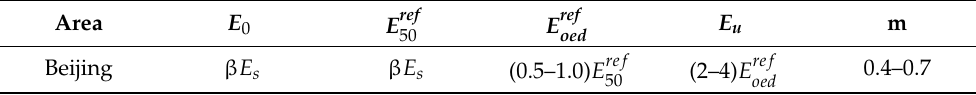
Table 2. Empirical values of nonlinear stiffness parameters of the modified Mohr-Coulomb constitutive